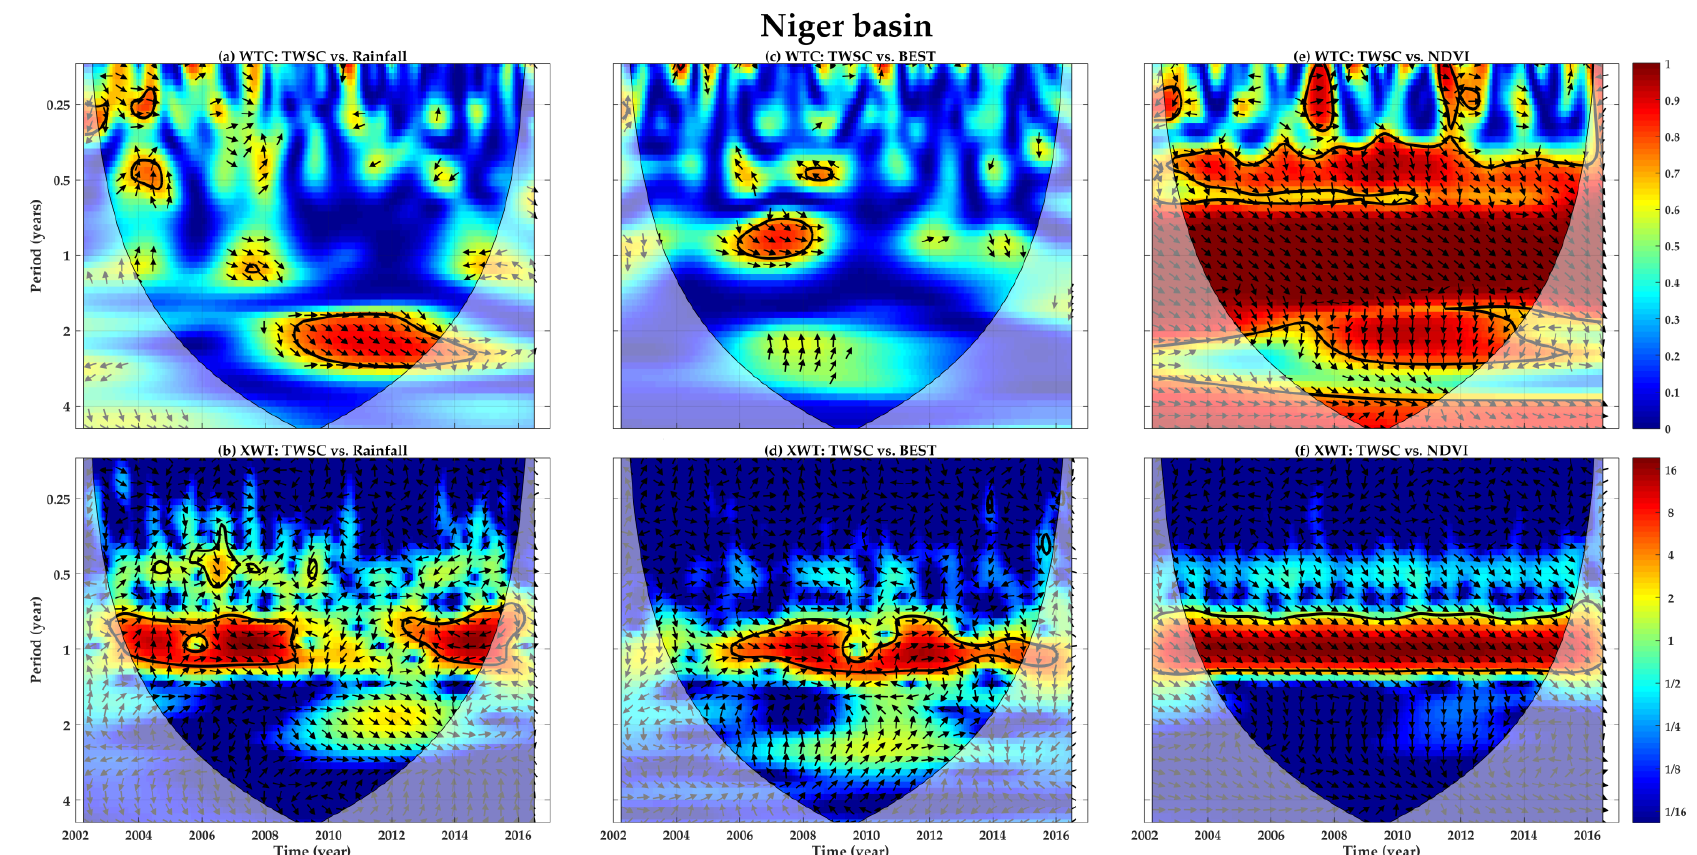
Figure 11. Wavelet coherency (WTC) and the corresponding cross-wavelet coherency (XWT) showing the interactions between the regional TWSC of the Niger Basin and the TRMM rainfall ( a , b ), the BEST ( c , d ), and the NDVI ( e , f ). Black contour lines indicate the 95% confidence level against the red noise between the variables, while the shaded cone represents the cone of influence (COI). The relative phase relationships are denoted by arrows designating phase difference between two variables A and B. The phase arrows pointing right ( → ) depict the in-phase, those pointing left ( ← ) depict the anti-phase, those pointing down ( ↓ ) indicate that A is leading B by 90°, and those pointing up ( ↑ ) indicate that B is leading by 90°.